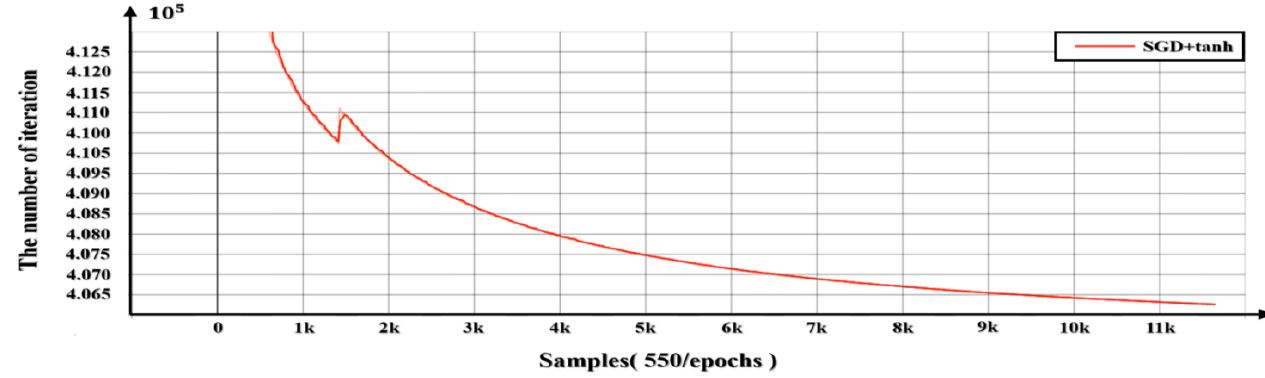
Figure 9. The loss function curve of SGD+tanh solution method.